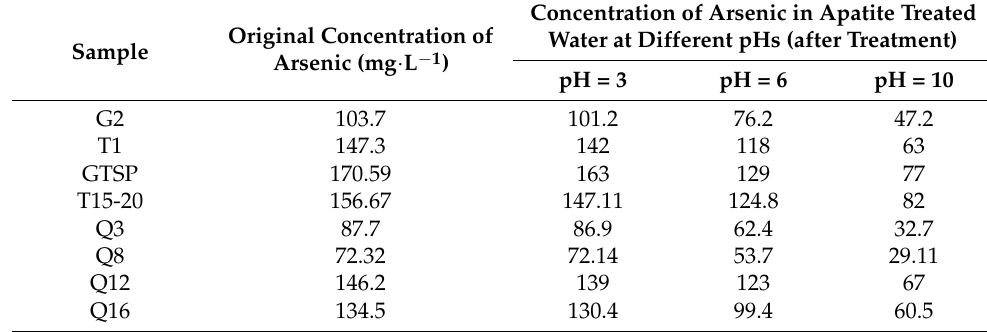
Table 1. Concentration of arsenic in different apatite-soils.